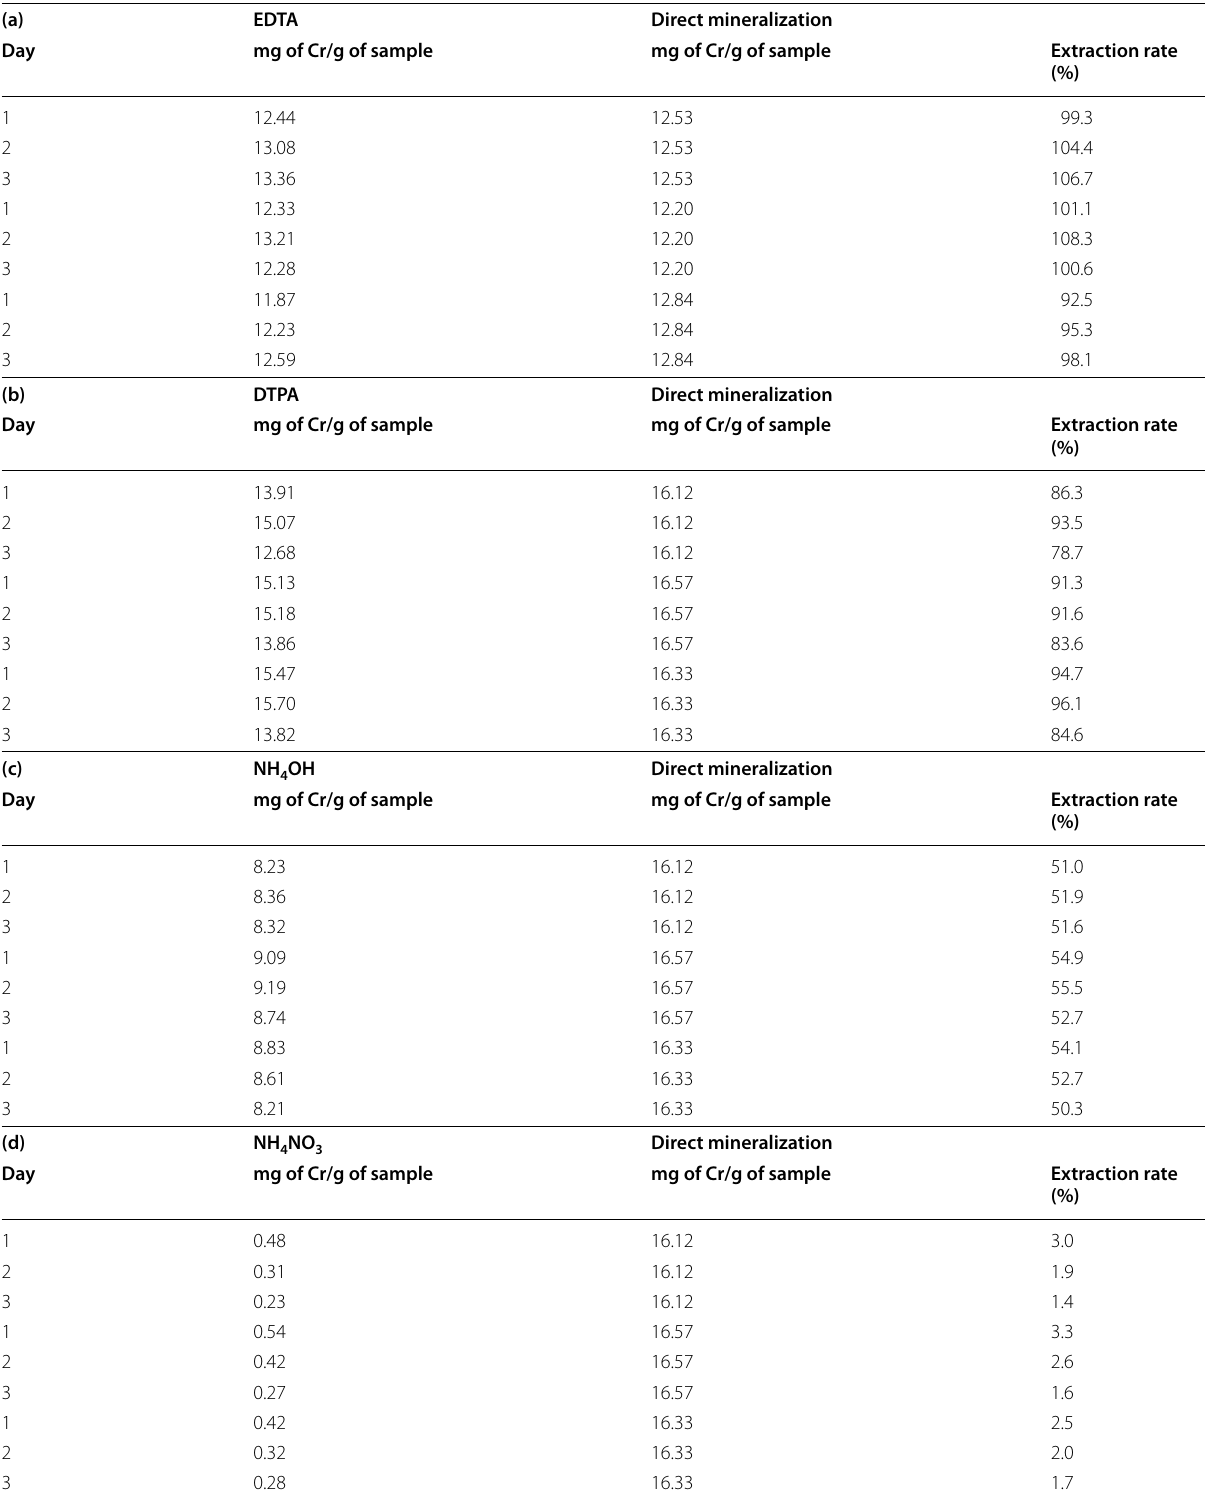
Table 3 Extraction rates of different pretreatment methods. Comparison between direct mineralization and: a EDTA extraction;